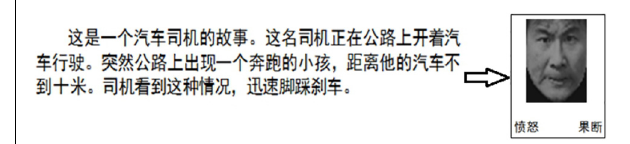
FIGURE 2 | An example of a trial of the FVT. The situational vignette is displayed as follows (in Chinese): This is a story about a bus driver. The driver is driving a bus on the road. Suddenly, he sees a running child on the road no more than 10 m ahead of his bus. He quickly steps on the brakes. Followed by the vignette, there appears a picture of a face on the upper and two choices (angry vs. determined) on the lower position. Subjects are required to choose the better one that reflects the given